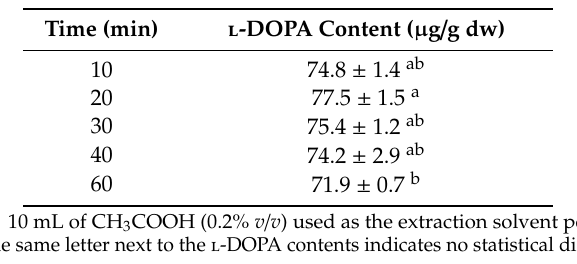
Table 2. Influence of the extraction time on l -DOPA extraction A from dry beans of V. faba var. major